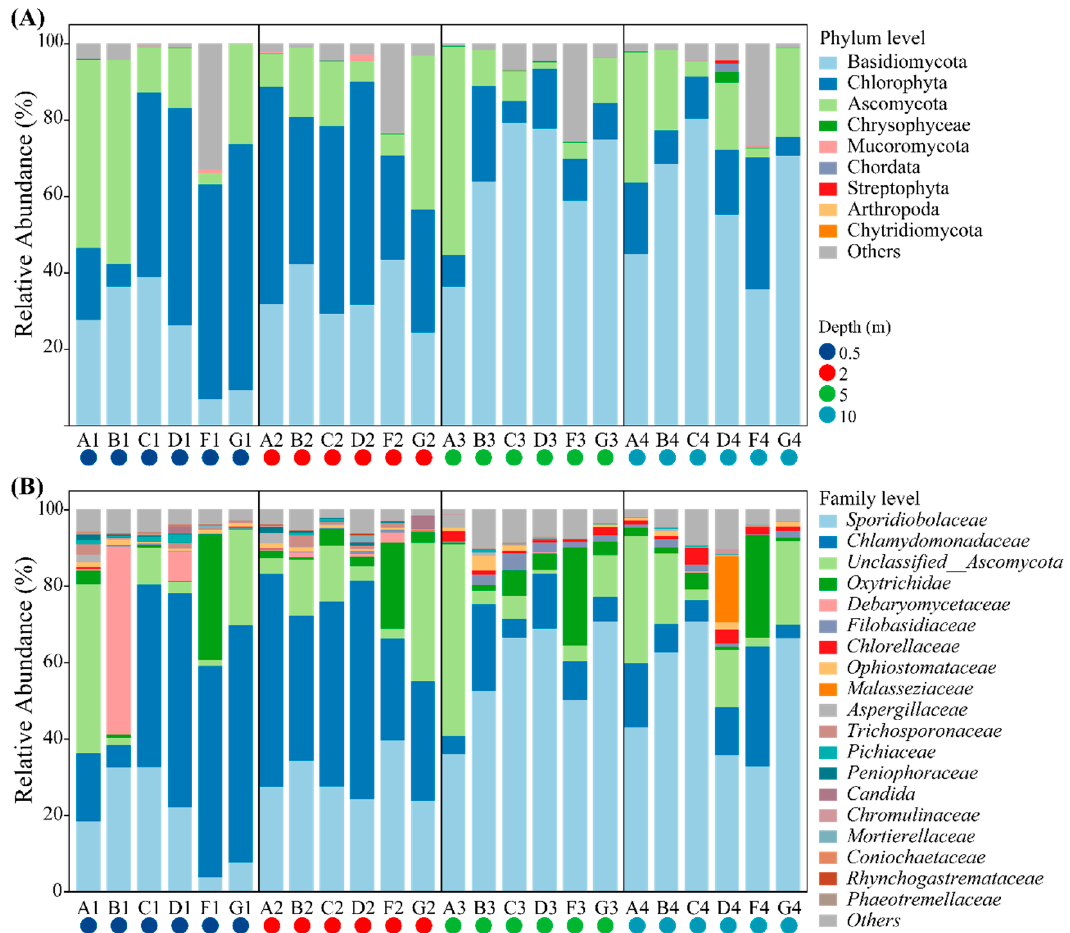
Figure 2. Composition of the eukaryotic community. Taxonomic assignments were conducted at phylum ( A ) and family ( B ) level.